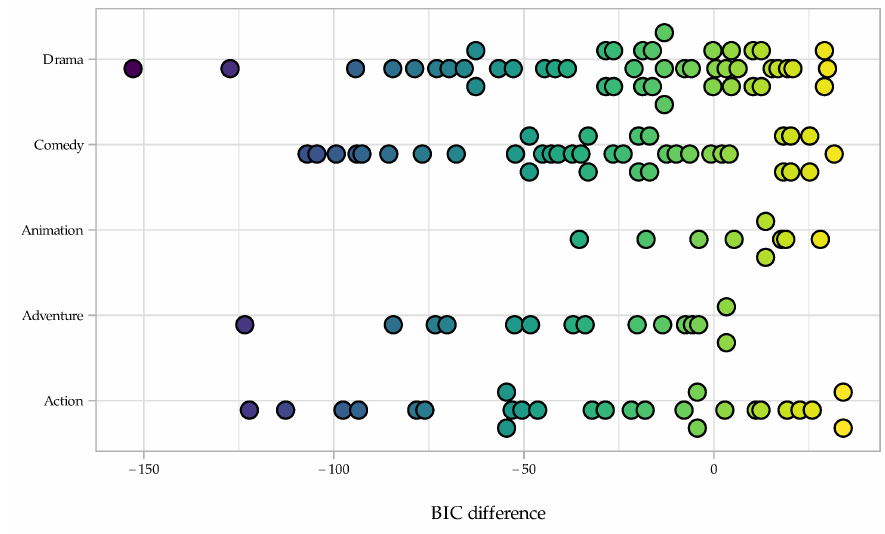
Figure 1 – Differences in Bayesian information criterion (BIC) for fitted three-parameter Dagum distribution and two-parameter lognormal distribution for shot length data of 134 Hollywood films released from 1935 to 2005 (Source: Cutting et al. (2010); http://www.cinemetrics.lv/ database.php ). Negative differences indicate the Dagum distribution is the preferred